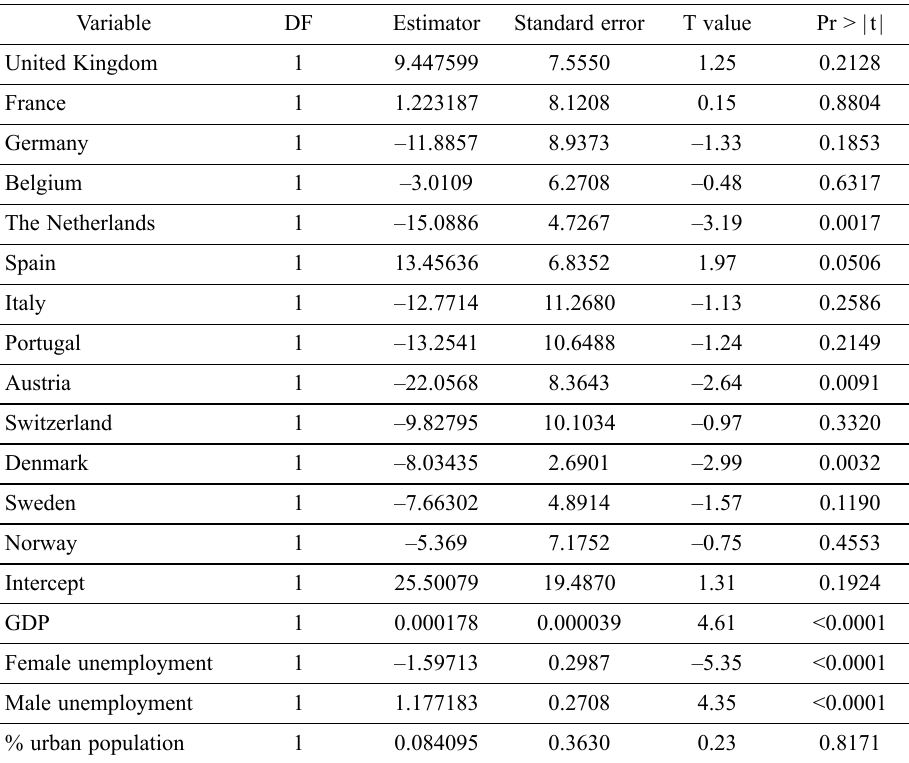
Table 6. Parameter estimates, volume as dependent